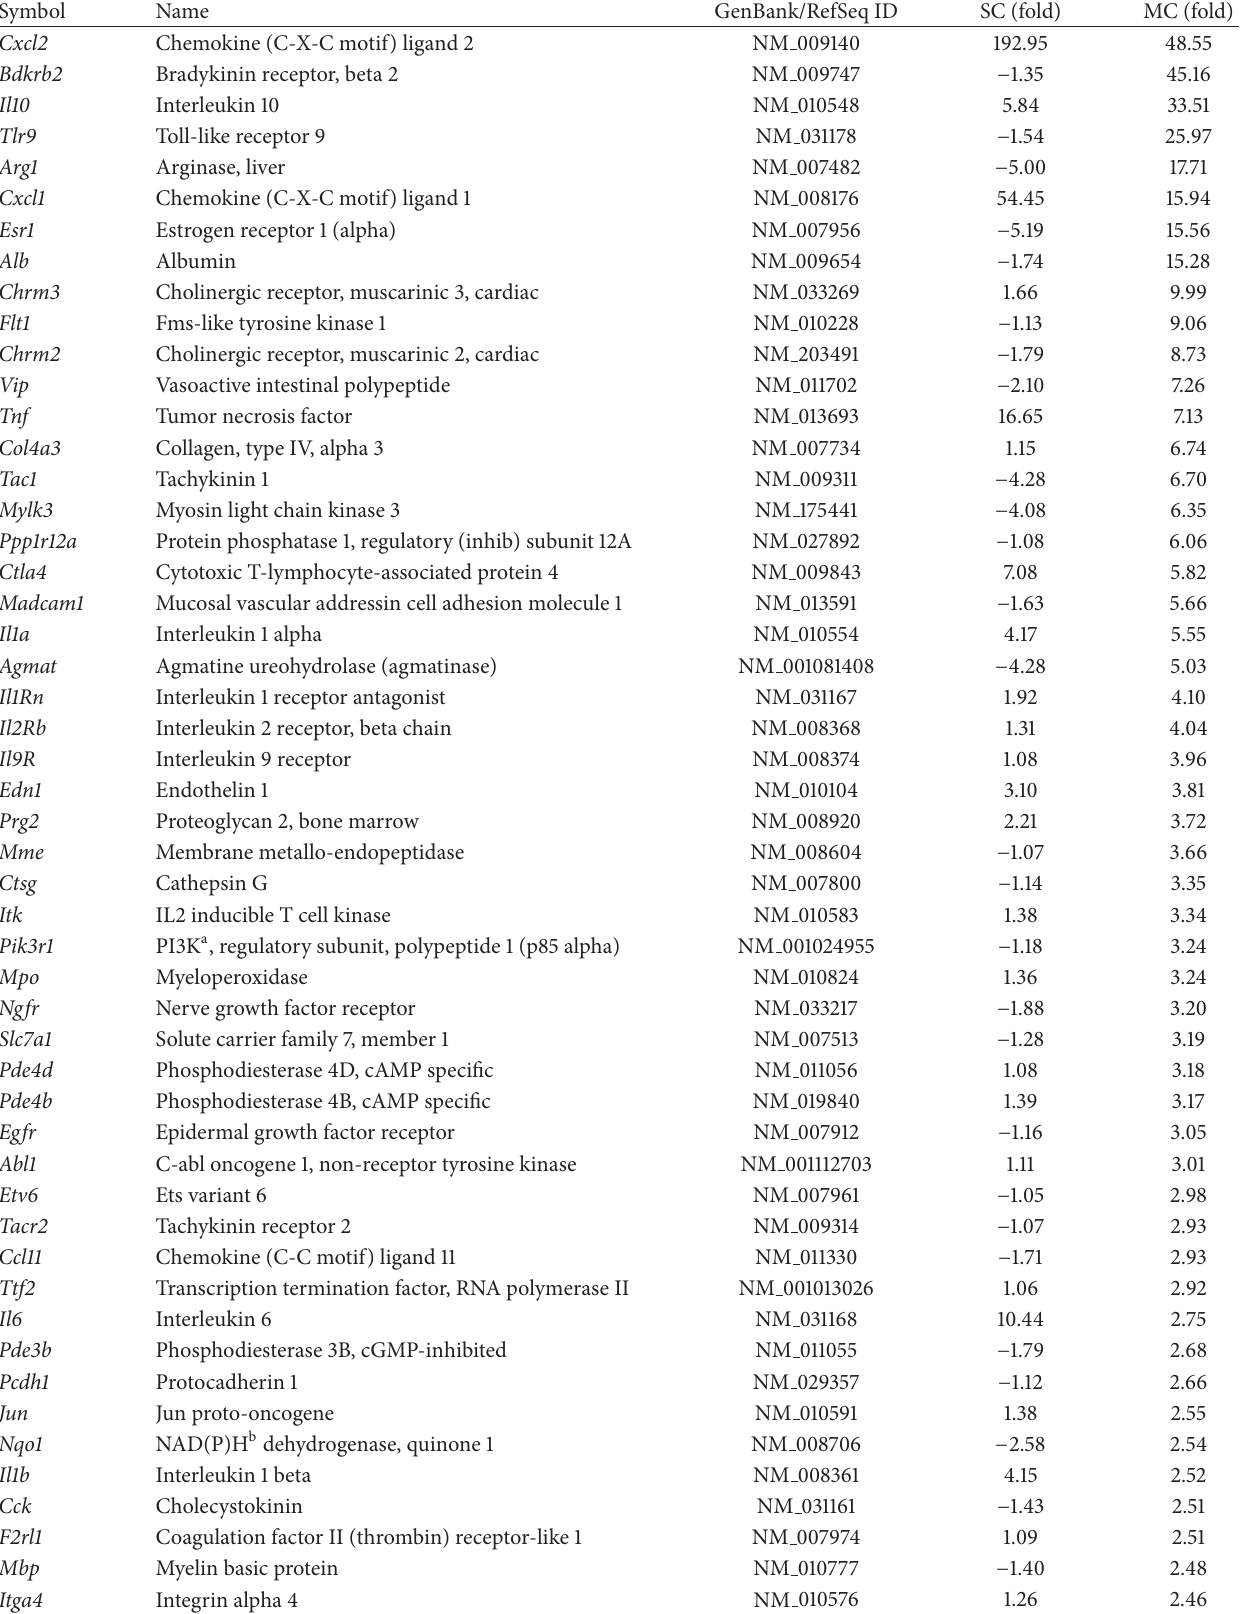
Table 2: OGG1-BER induced expression of genes associated to